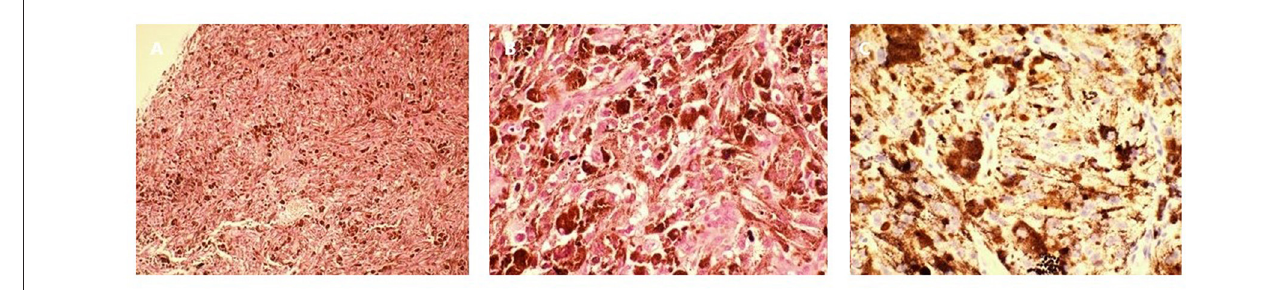
FIGURE 6 | Pathology of the lesion resected during the second surgery. (A) Hematoxylin and eosin staining (x100). (B) Hematoxylin and eosin staining showing multiple anaplastic cells and mitotic figures (x400). (C) Ki-67 immunostaining (x400).